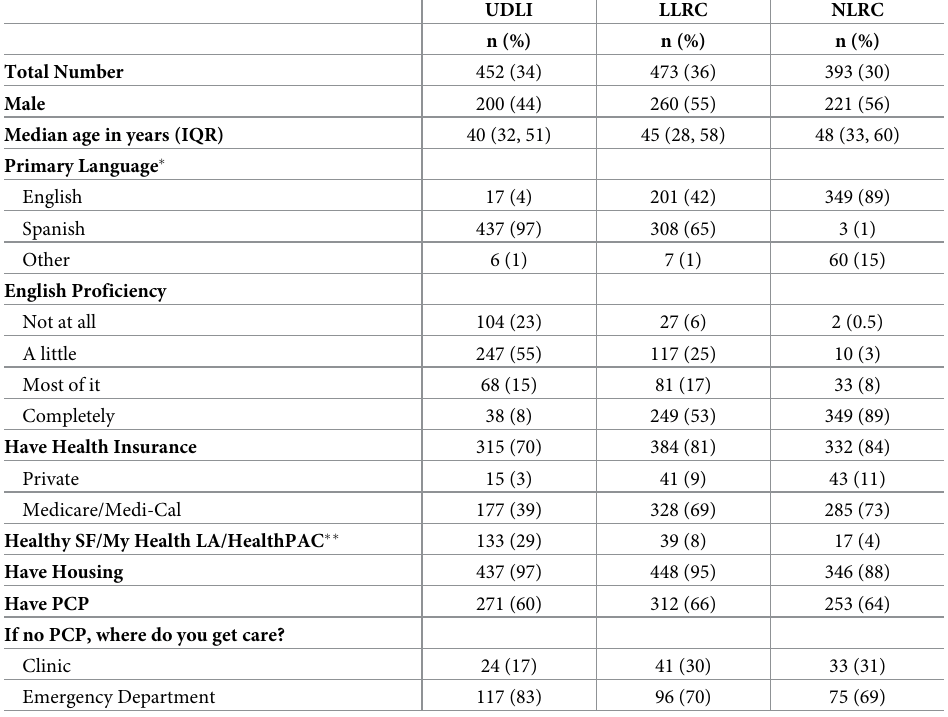
Table 1. Patient characteristics sorted according to study